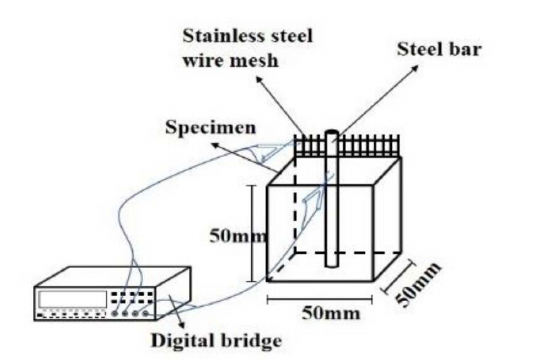
Figure 2. The schematic diagram of AC electrical resistance measurement. The DC power with the maximum voltage of 1 V was provided for the measurement of electrical resistance time history curves. The DC voltage was collected by an